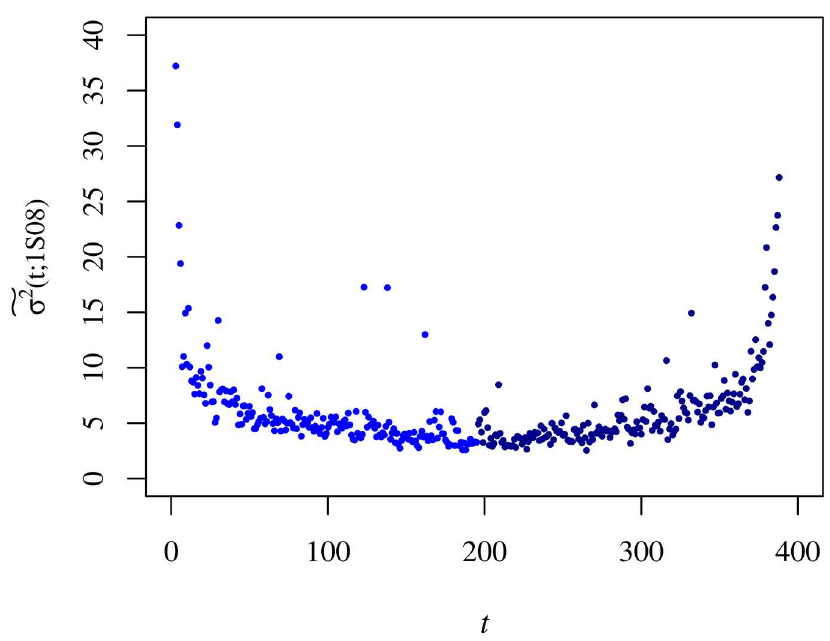
Fig 7. Variance of the trading volume, e s 2 ð t ;1 S 08 Þ v t . The curve corresponds to semester 7 (1S08) and it was normalisedby a factor 10 8 . We use different tones of blue to turn the distinction between the morning and afternoon parts of the session